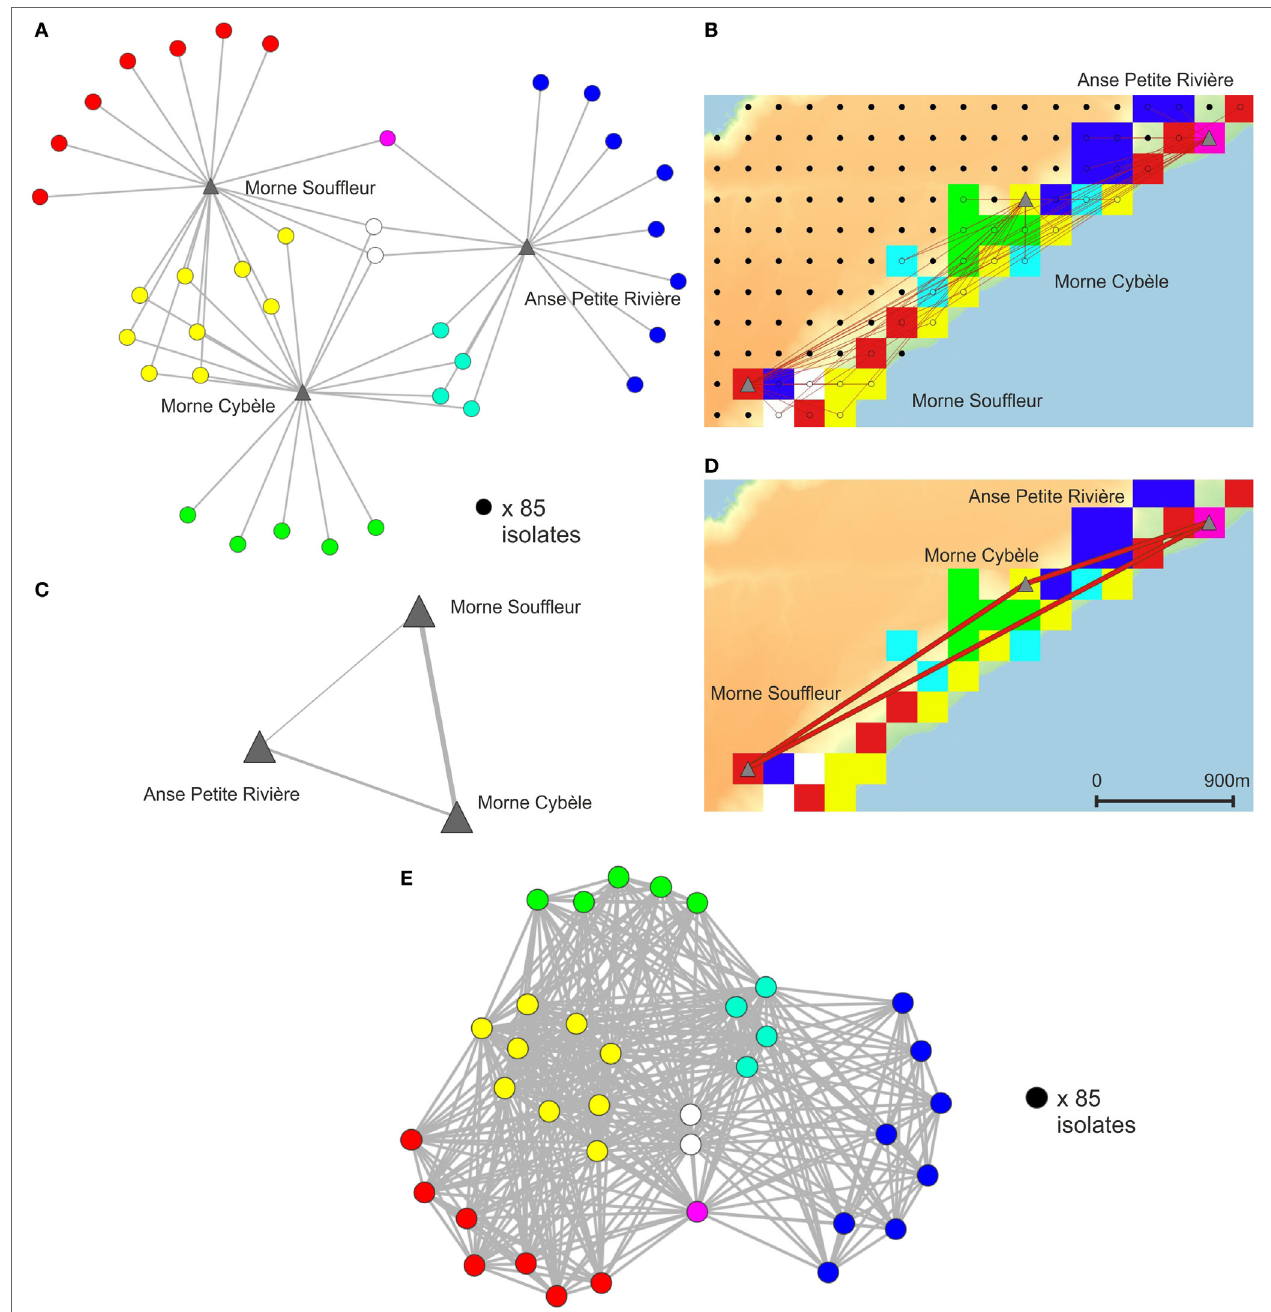
FigUre 3 | A two-mode representation of a cumulative viewshed, where one mode (triangles) represents sites and the other (circles) represents landscape locations (a,B) . From this, two one-mode projections can be derived representing either the sites connected through the mutual visibility of landscape locations, i.e., the second-order visibility graph, (c,D) or the landscape locations connected through being visible from a pair of sites (e) . Color coding is used to identify locations visible only from Morne Souffleur (red), only from Morne Cybele (green), only from Anse Petite Riviere (blue), from pairs of sites (cyan, yellow, purple), and from all three